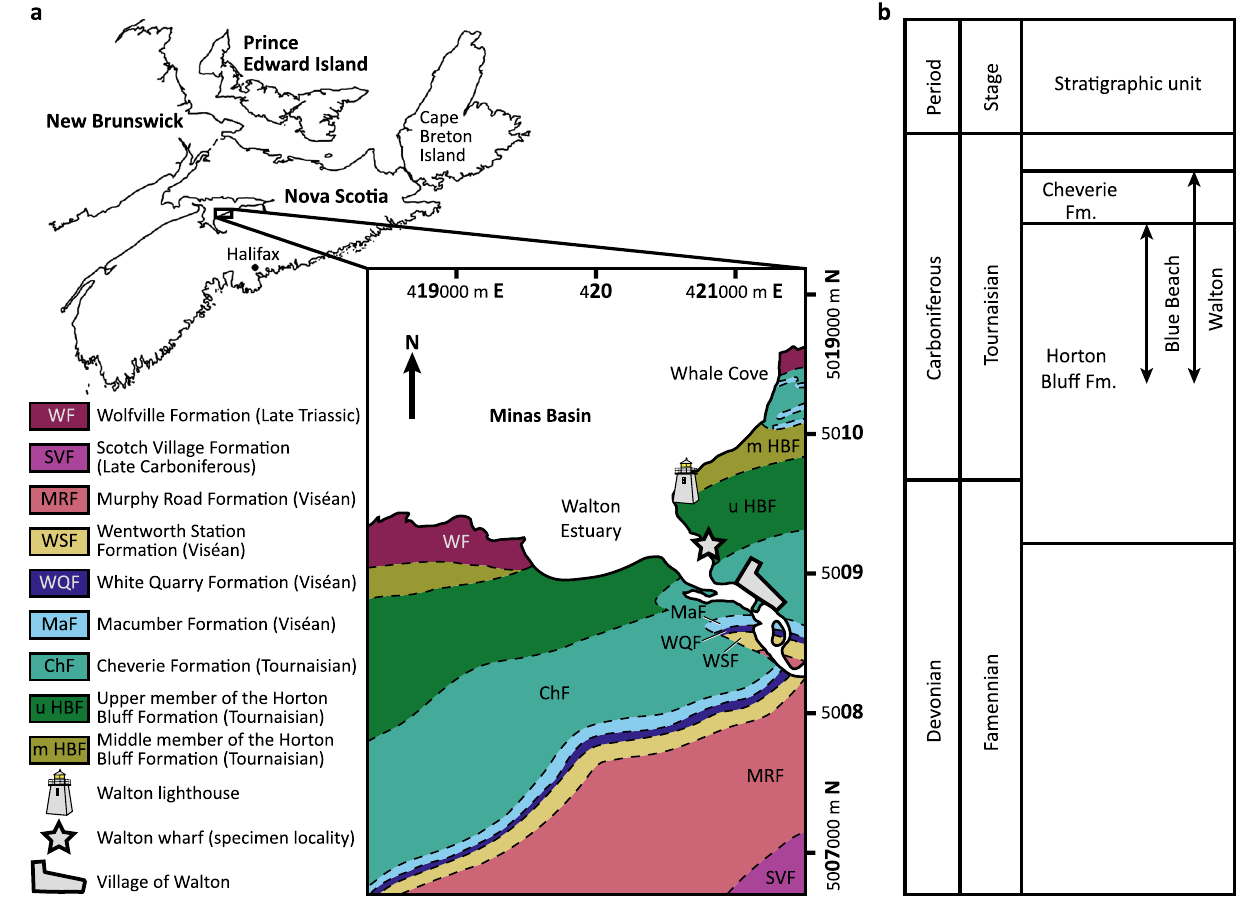
Figure 2. Geographic and stratigraphic context of specimen locality. ( a ) Geography and bedrock geology of Walton, Nova Scotia. Map of Nova Scotia modified from Anderson et al. 32 ; map of Walton area modified from Moore et al. 30 . Numbers on map margins are UTM coordinates. ( b ) Schematic stratigraphic column of Blue Beach and Walton, Nova Scotia modified from Martel et al. 33 the anterior flank, the posterior ridges of ornamentation undertake a forward-facing s-curve so that the ven- tral part of the ridge is anterior. Occasionally, curvature in successive ridges opens space where a new ridge is added; usually, the general decrease in ridge curvature in successive rows results in ridges in the middle of the scale pinching out. In some tall scales of the posteroventral quadrant of the flank, the pattern is reversed. Ridges along the posterior margin are straight and vertical, but some are interrupted as more anterior ridges curve posteriorly as they run ventrally. In some displaced scales in the posterior flank the dorsal and anterior margins form a flange devoid of ornamentation. In lateral line scales, the ornamentation takes a similar but more drastic curve around the lateral line notch. Dorsal to the level of the notch, this forces the ornamentation to form concentric, forward-opening arcs that straighten out in successive rows towards the anterior, sometimes pinching out ridges in the middle of the dorsal part of the scale. Ventral to the lateral line notch, the ornamentation straightens and becomes vertical. Guard scales. A single row of guard scales runs parallel to the base of the dorsal and anal fins (dgs and ags, Figs. 3, 4, 5 and 6), overprinting the pattern of curved scale rows in the flank. The dorsal guard scales (dgs, Figs. 3, 4 and 5) are slightly larger than nearby scales and bear curved ornamentation running subparallel to the ventral margin of the dorsal fin. Posterior ridges form concentric arcs, more anterior ridges are often straighter, and are occasionally truncated by the arc of posterior ridges. The anal guard scales (ags, Figs. 3, 4 and 6) are at least three times larger than adjacent scales and become larger anteriorly. The ornamentation of the anal guard scales is deeply curved and generally subparallel to the dorsal margin of the anal fin (Fig. 4c). Posterior ridges of the scale, if present, are briefly parallel to the posterior margin of the scale, then curve forward, following the ventral margin. These long posterior ridges are usually present in anterior anal guard scales and absent in poste- rior anal guard scales. Anterior ridges form tight forward opening arcs, small, nearly tuberculate ridges parallel to the dorsal and ventral margins, long s-shaped striae wrapping around multiple smaller ridges, or curve gently anteriorly as they run ventrally.